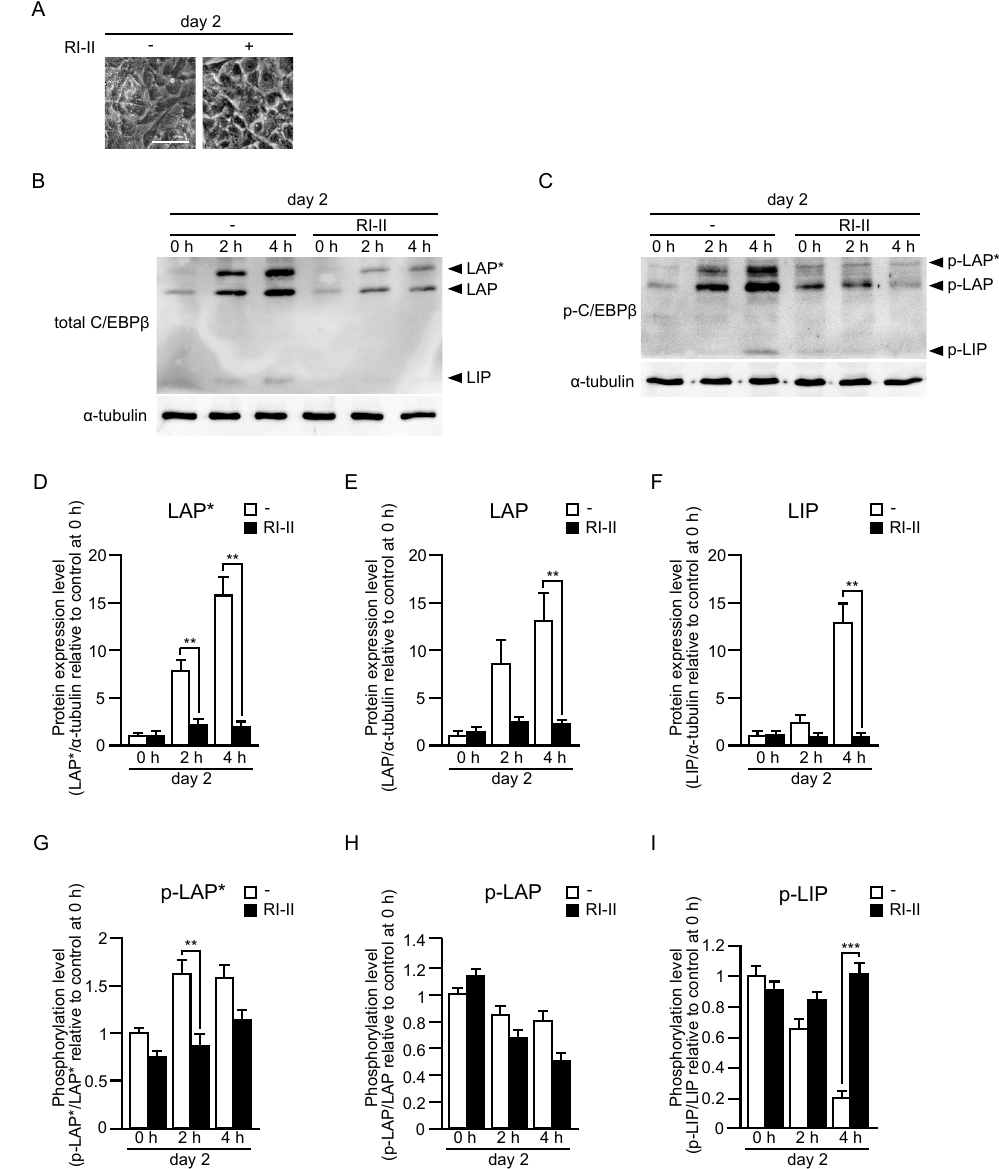
Figure 5. Protein and phosphorylation levels of three C/EBP β variants in the early stage of dif- ferentiation of adipose progenitor cells into adipocytes in vitro. ( A ) Phase-contrast images of cells derived from control mice in the presence or absence of RI-II at day 2. Scale bar, 50 µ m. Protein ( B ) and phosphorylation ( C ) levels of three C/EBP β variants (LAP*, LAP, and LIP) in cells derived from control mice in the presence or absence of RI-II were determined by immunoblot analysis using antibodies against C/EBP β ( B ) and phosphorylated C/EBP β ( C ), respectively. α -tubulin served as a loading control. Intensities of bands for LAP* ( D ), LAP ( E ), LIP ( F ), p-LAP* ( G ), p-LAP ( H ), and p-LIP ( I ) in immunoblots were quantified. Data are shown as means ± S.E. ( n = 3). ** p < 0.01, *** p < 0.001 (Student’s t